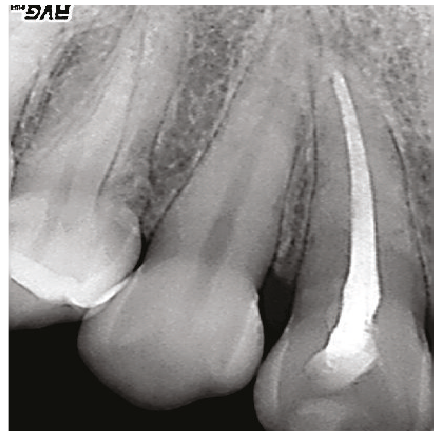
Figure 16: Radiographic examination after 12 months.